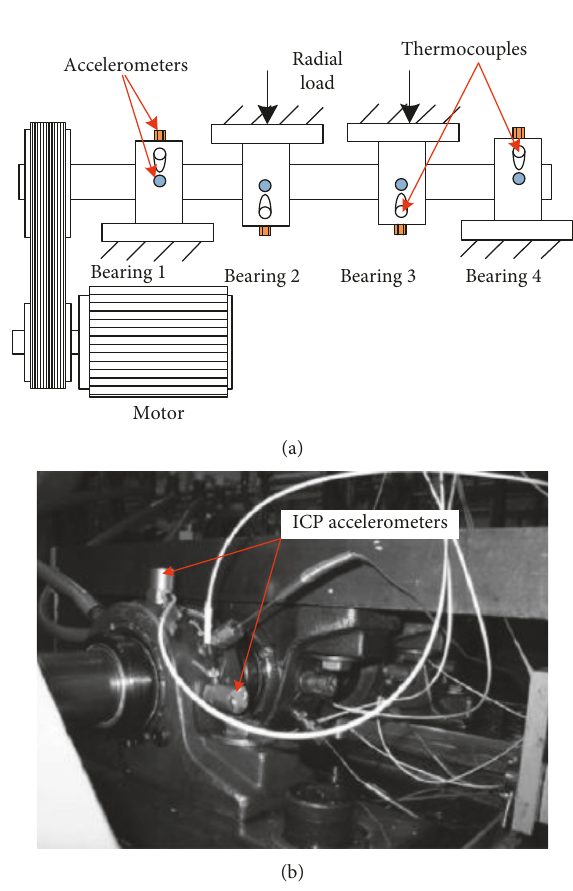
Figure 6: Bearing test rig and sensor placement illustration.